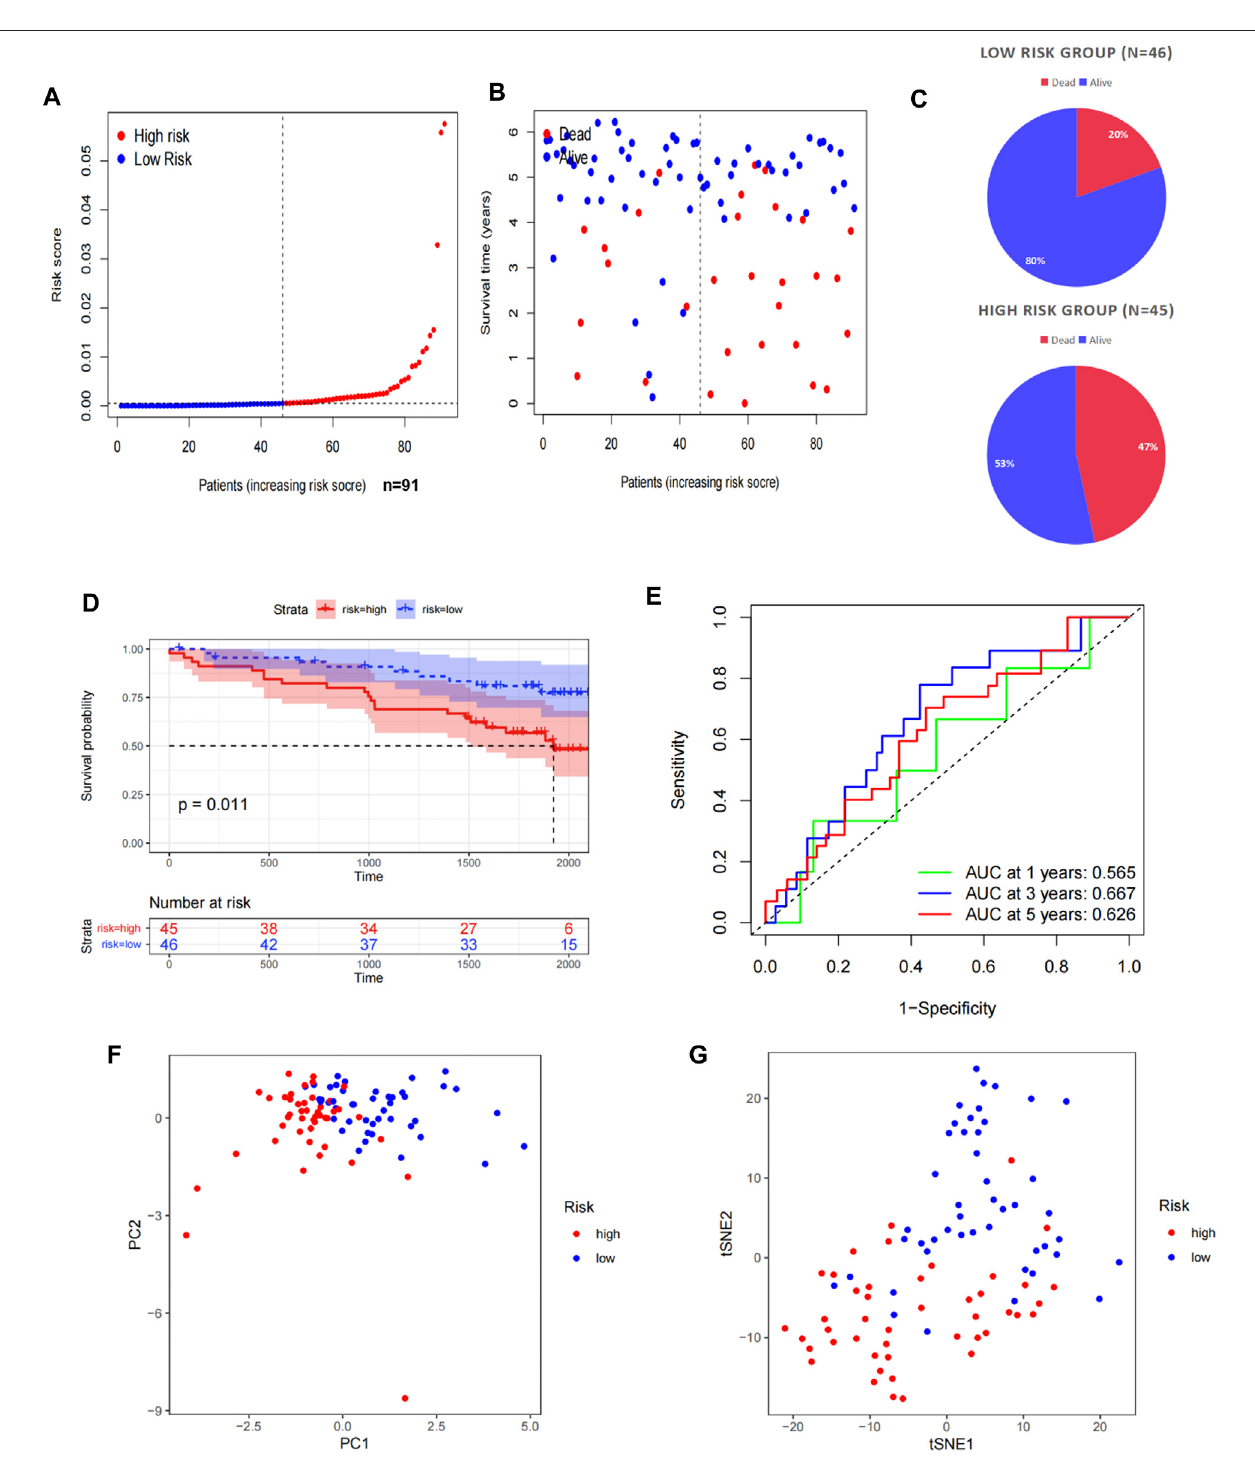
FIGURE 3 | Validation of the prognostic signature in the ICGC. (A) Distribution of the risk scores in the low- and high-risk groups. (B,C) Patient distribution in the low- and high-risk groups based on the survival status. (D) OS curve strati fi ed by the low- and high-risk groups. (E) Time-dependent ROC curves for OS prediction by ASRG-based signature. (F,G) Two risk groups were distinguished by PCA and t-SNE.